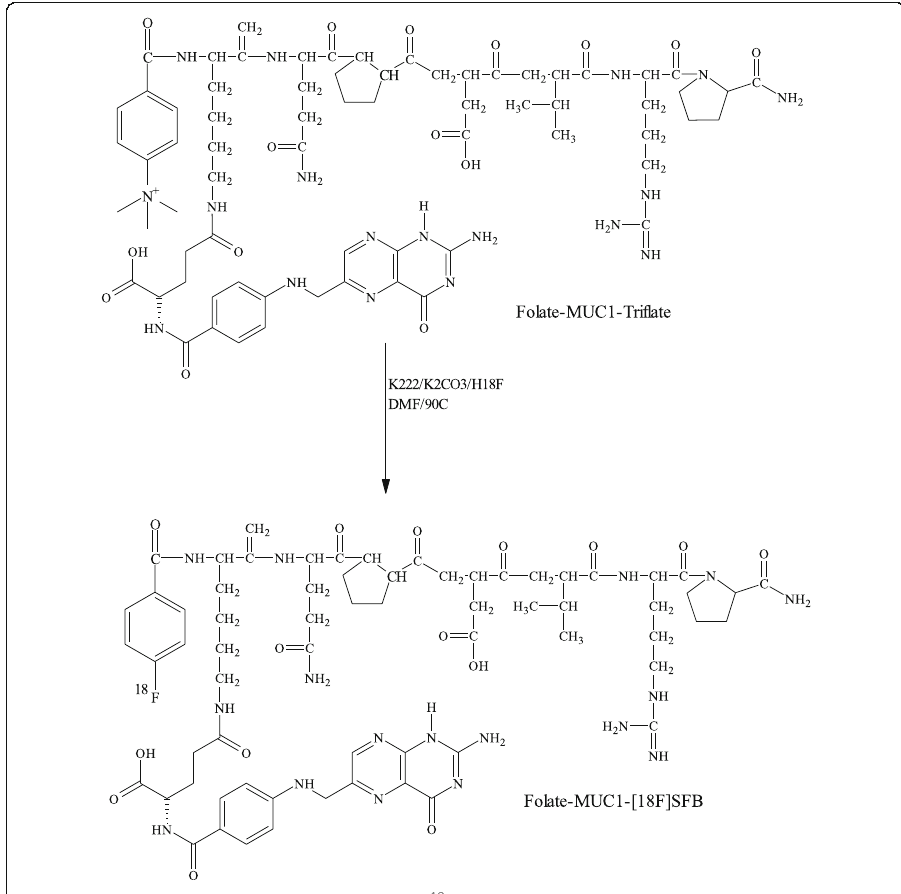
In vivo biodistribution Approval for the animal protocol used in this study was obtained from the Insti- tutional Animal Care and Use Committee. Animal biodistribution experiments were performed according to the international regulations governing the safe and humane use of laboratory animals in research (Guide for the Care of and Use of Laboratory Animals, 1996). The biodistribution was performed in normal female Balb/c mice ( n = 4 at each time point; body mass 20-25 g) to ascertain the in vivo distribution profile of the MUC1-[ 18 F] SFB and MUC1-FA-[ 18 F] SFB hybrid peptide conjugates. Mice were injected via the lateral tail vein with 100 μ L of the radiotracers formulated in saline. Each dose contained ~ 10 μ g of the peptide and ~ 20 μ Ci (740 kBq) of radioactivity. Animals were sacrificed at different time intervals and tissues of interest were dissected, weighed and assayed for radioactivity. The percentage of the injected dose per gram (% ID/g) was then calculated by counting all tissues in a γ -well counter using a stored sample of the injection solution as a standard to estimate the total dose injected per